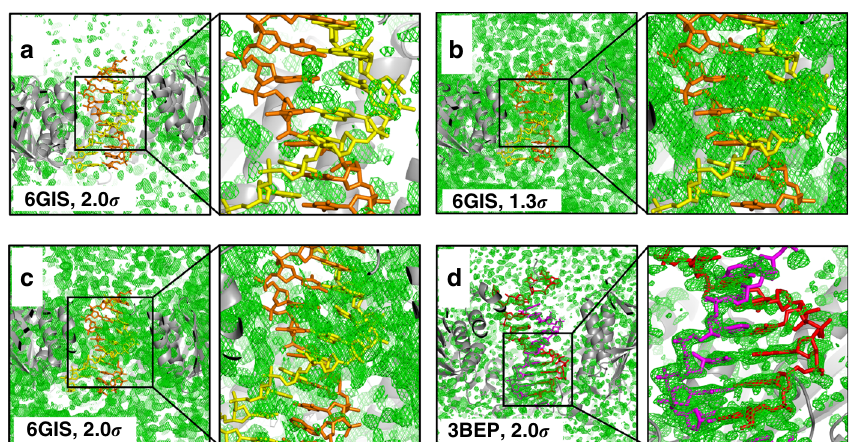
Fig. 1 Assessment of the electron density of putative DNA in PDB 6GIS. a Simulated annealing difference omit map (mFo-DFc), contoured at 2.0 σ , overlaid with the model of DNA from the crystal structure, showing no evidence of DNA bound to the interior of PCNA. The DNA strand that interacts with the protein is colored yellow, and the complementary strand is colored orange. b Same difference map at 1.3 σ . Note that the noisy density also covers parts of the protein, indicating that the contour level is too low, but still does not correspond to the DNA. c Polder omit map contoured at 1.3 σ , showing copious density, but not corresponding to DNA, particularly on the lower left of the yellow strand, which purportedly interacts with PCNA. In order to generate an effective omit map, we removed the DNA (7.2% of the total atoms), and ran simulated annealing using PHENIX 11 to decrease bias from the starting model. We also removed all TLS and NCS parameters, and used group B factors (2 values per residue, in consideration of the relatively low resolution: 2.82 Å), but no other adjustments were made to the model. This resulted in a signi fi cant drop in both Rwork (from 24.7 to 19.5%) and Rfree (from 28.4 to 24.9%), and the fi nal geometry was also improved (RMSD bonds from 0.016 to 0.008Å, and RMSD angles from 1.8 to 1.0°), clearly indicating a large improvement in the model. The RMSD between the starting structure and the fi nal structure was 0.51 Å for all protein atoms. In order to con fi rm that the improvement in Rwork and Rfree were not resulting from differences between Phenix and REFMAC 12 , the output from Phenix was run through REFMAC, giving a fi nal R- work of 19.1%, and Rfree of 24.6%. d Simulated annealing difference omit map, for 3BEP, contoured at 2 σ . Images made in